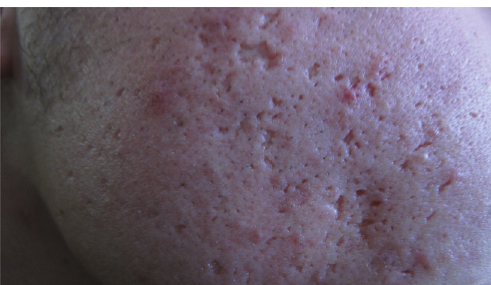
Figure 2: Icepick